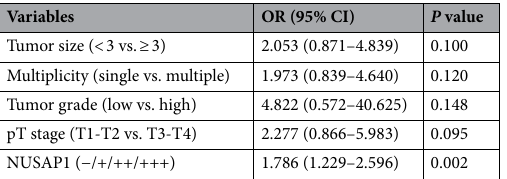
Table 5. Logistic regression analysis of factors influencing lymph node metastasis in urothelial carcinoma of the bladder.